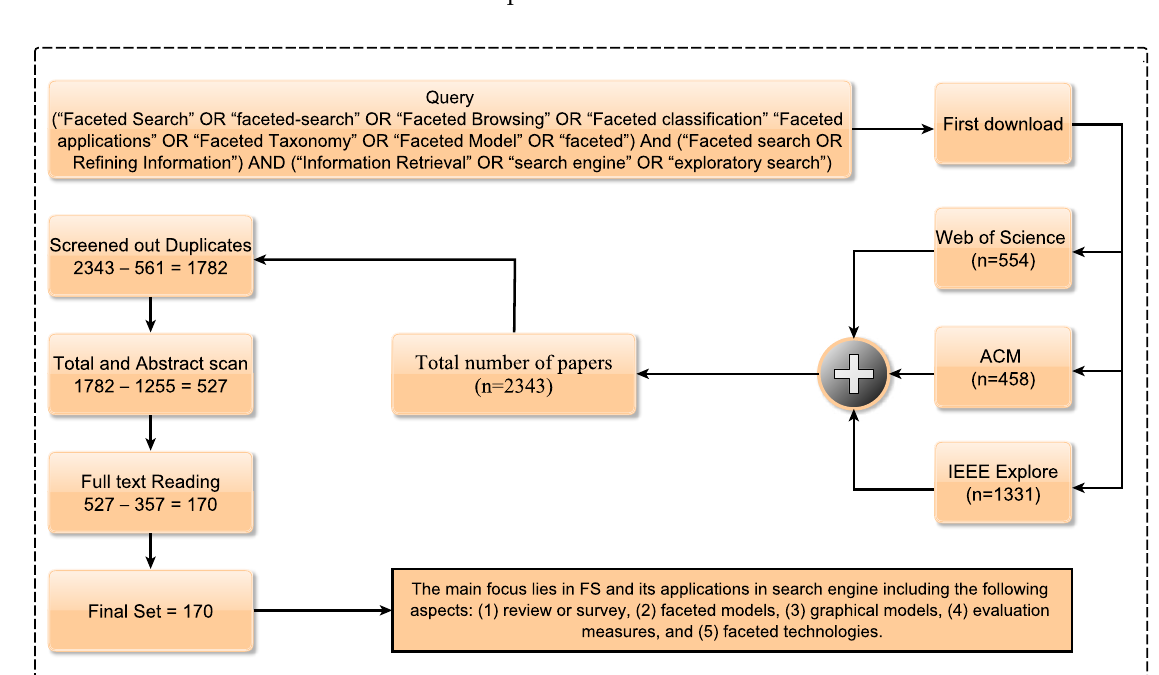
Figure 3. Research methodology